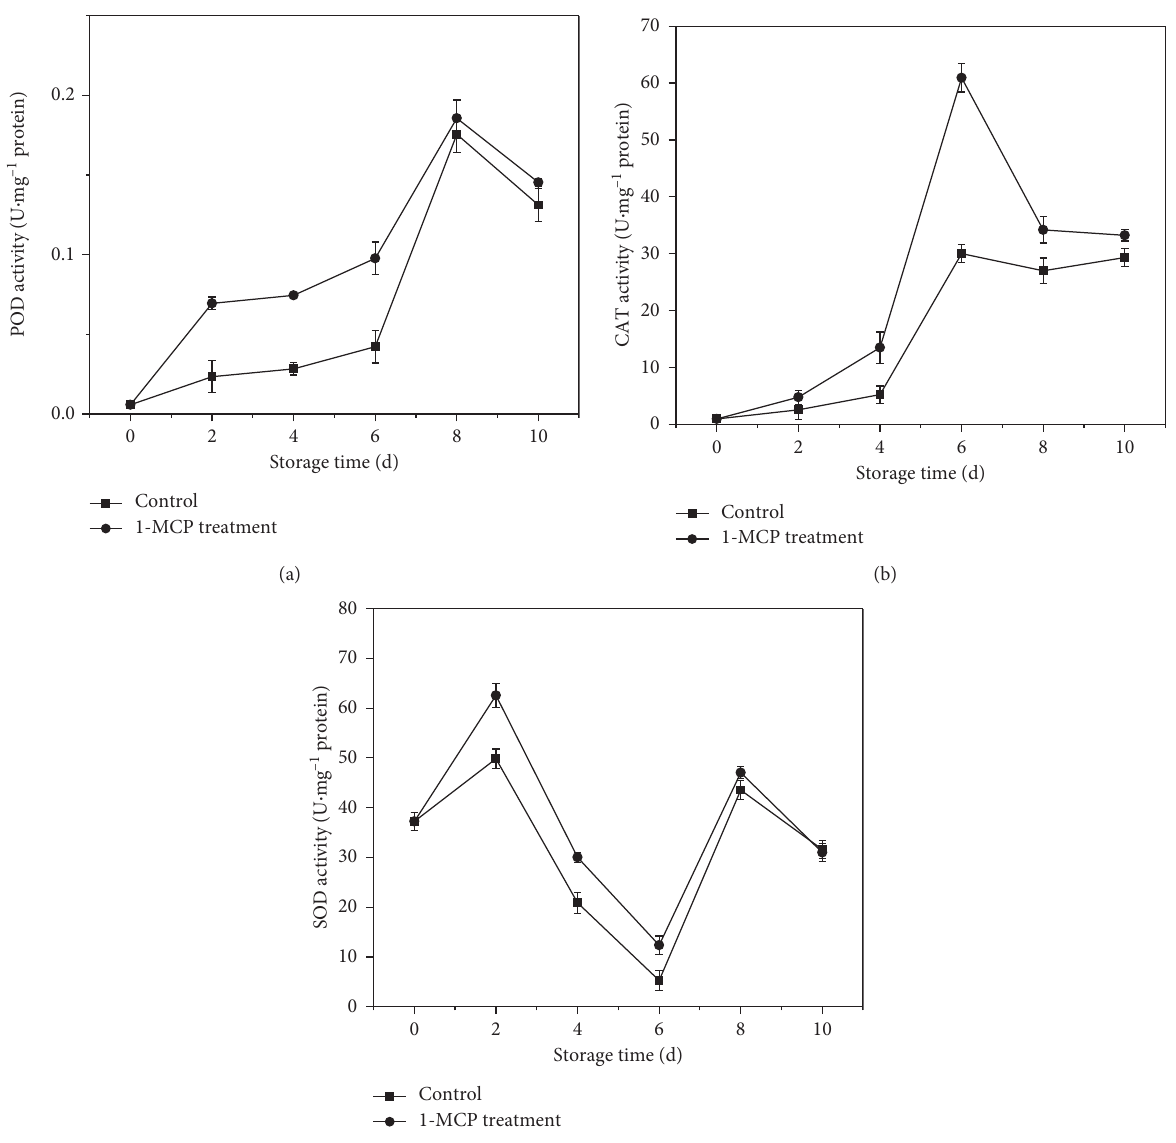
Figure 5: Effects of 1-MCP treatment on POD activity (a), CATactivity (b), and SOD activity (c) of mango fruit during storage at 25 ° C. The data are the means of triplicates ± standard